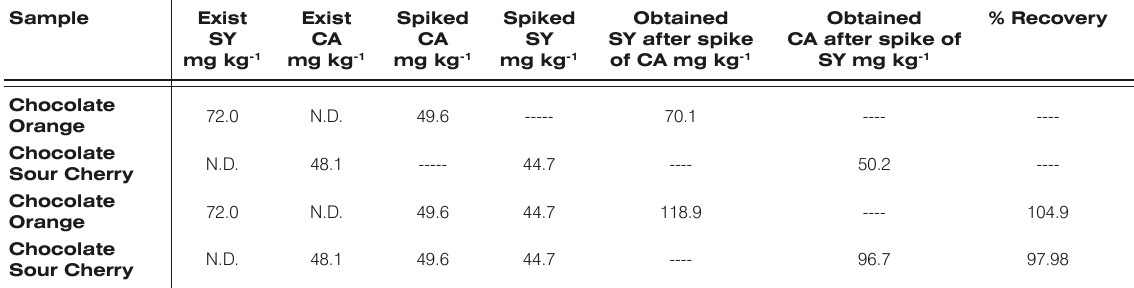
Table 4. Real samples and spiked samples for determination of SY and CA (mg kg -1 sample) in real samples. Sample